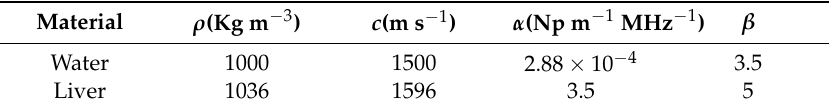
Table 1. Values of acoustic parameters in this study (37 ◦ C).